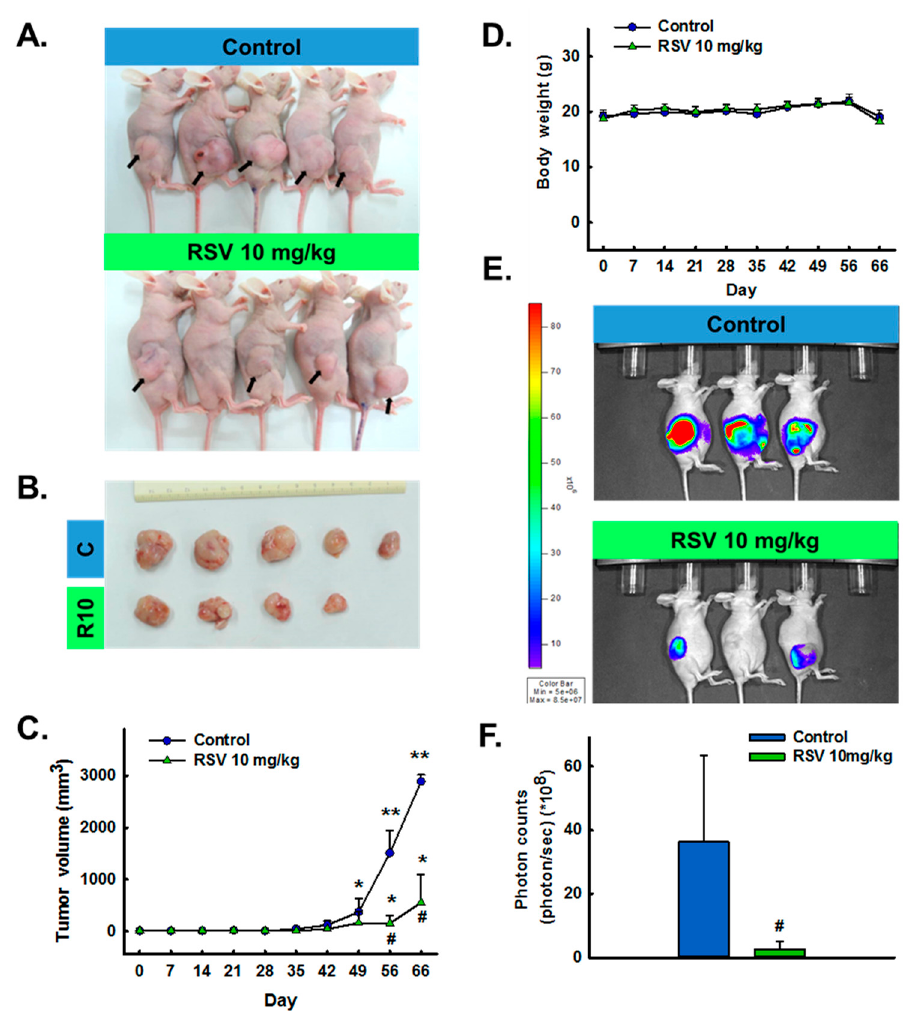
Figure 2. Effect of resveratrol (RSV) on tumor xenograft growth. ( A ) Morphology and ( B ) size of tumors isolated from the sacrificed mice in each group are shown at day 66, the end-point of the treatment. ( C ) Tumor volumes and ( D ) body weights of nude (Foxn1 nu ) mice. ( E ) Total photon flux from imaging on day 56 after xenografting. ( F ) All luciferase images were normalized to the same photon saturation scale. Data are presented as the mean ± SD ( n = 5 or 3); * p < 0.05 and ** p < 0.001 vs. day 0; # p < 0.05 vs. control.